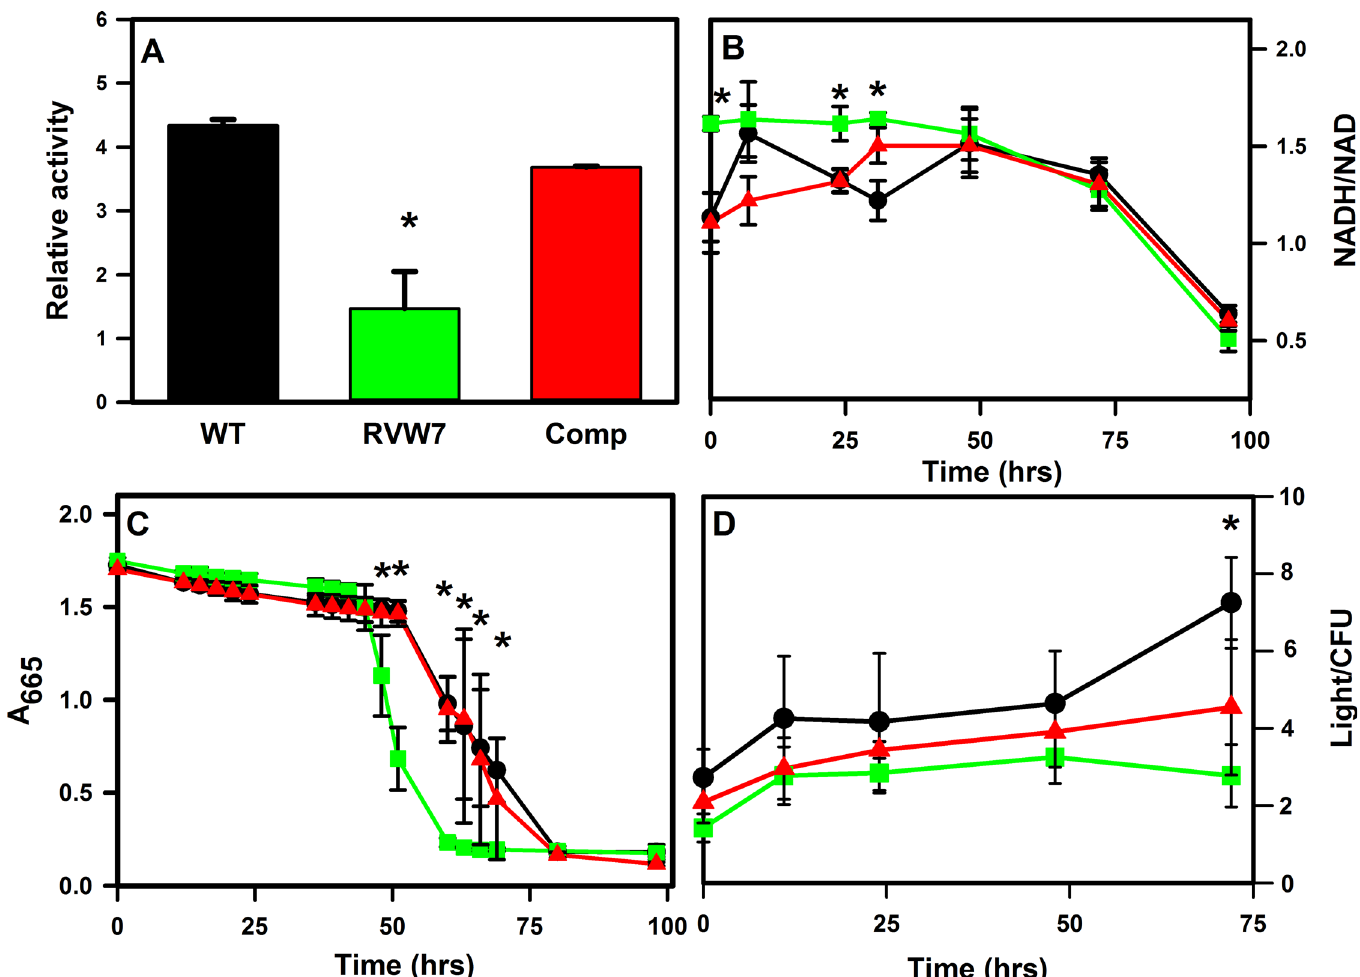
Fig 6. Physiological parameters of M . tuberculosis during reaeration. (A) Metabolic activity after extended hypoxia. Reducing activity was determined with XTT. Data are shown in arbitrary units. (B) The ratio of NADH to NAD. (C) Oxygen consumption was measured by methylene blue decolorization. (D) ATP levels in arbitrary units normalized to cell number. Black circles – WT, green squares – RVW7, red triangles – RVW7 pAld-Gen21. Asterisks indicate statistical significance (p < 0.05) of the comparison of RVW7 with WT.